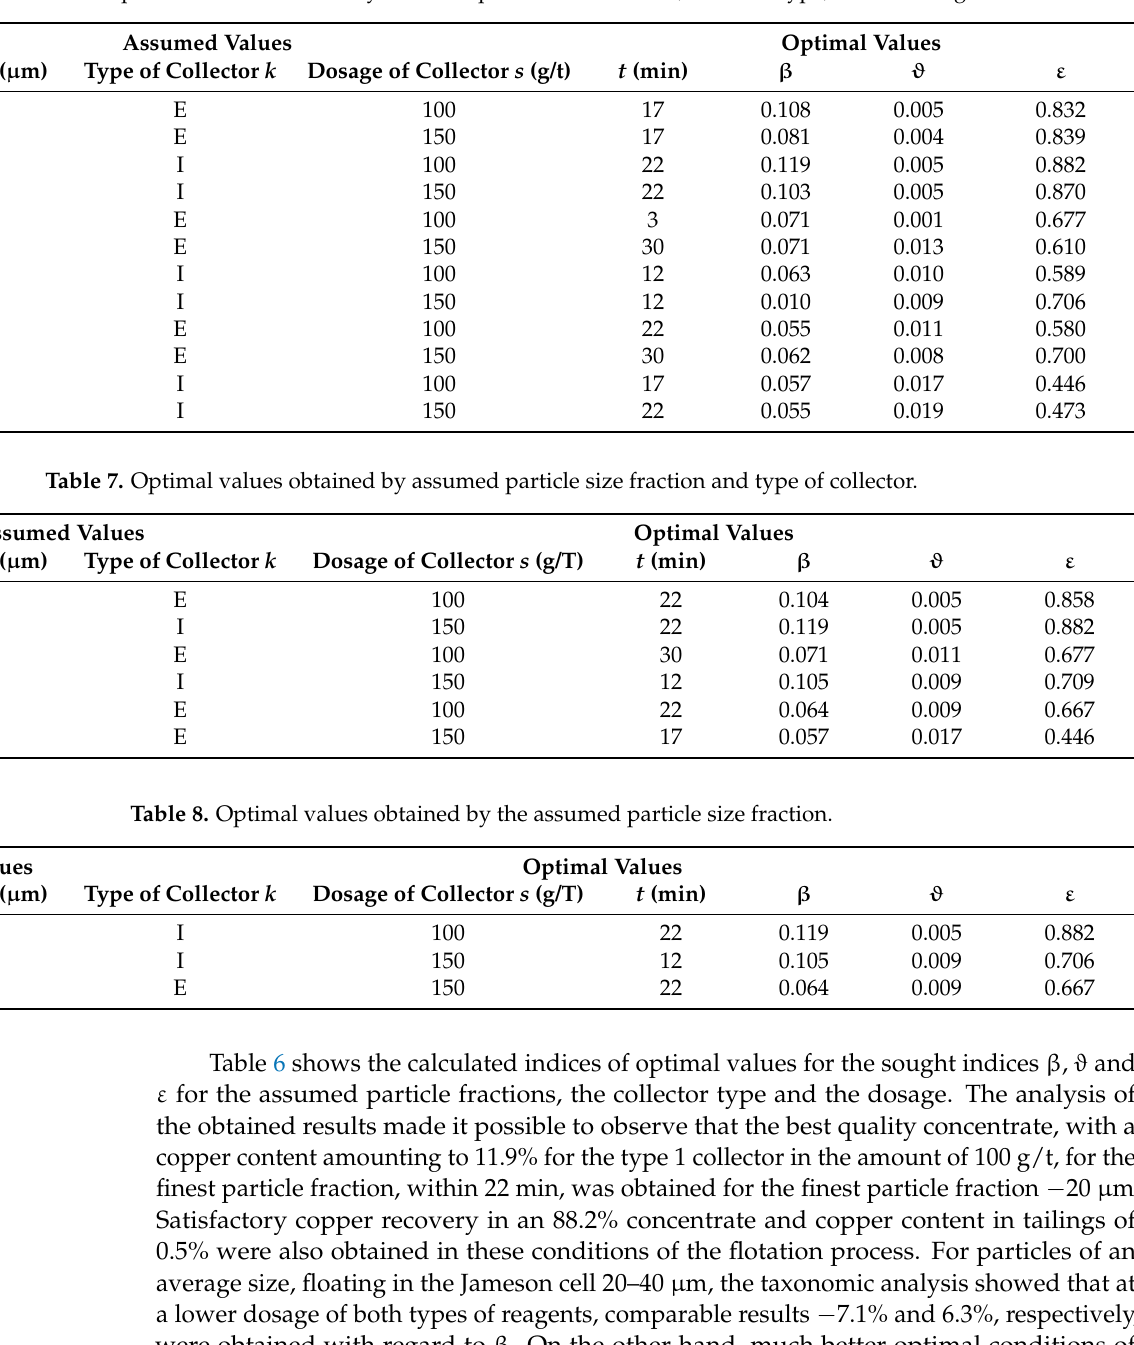
Table 6. The optimal values obtained by assumed particle size fraction, collector type, and its dosage.